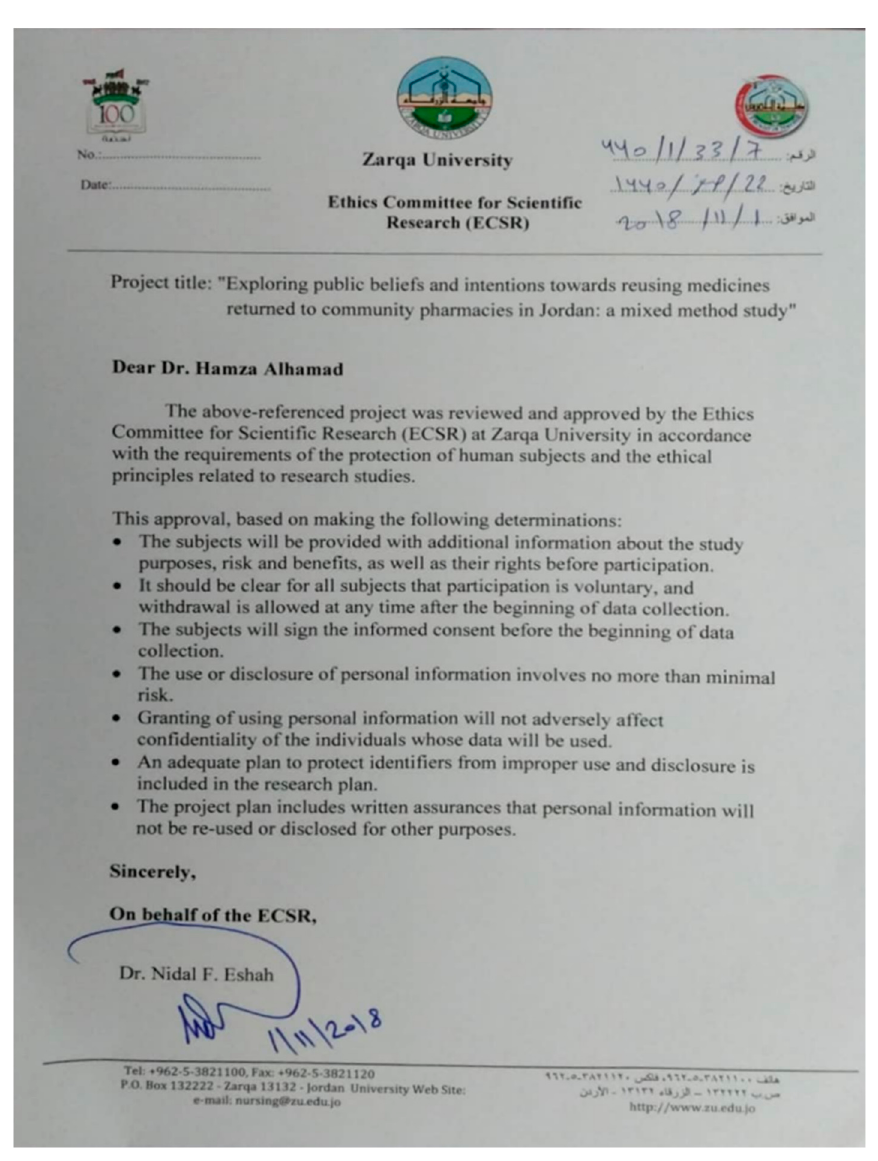
Figure A1. Ethics Approval.